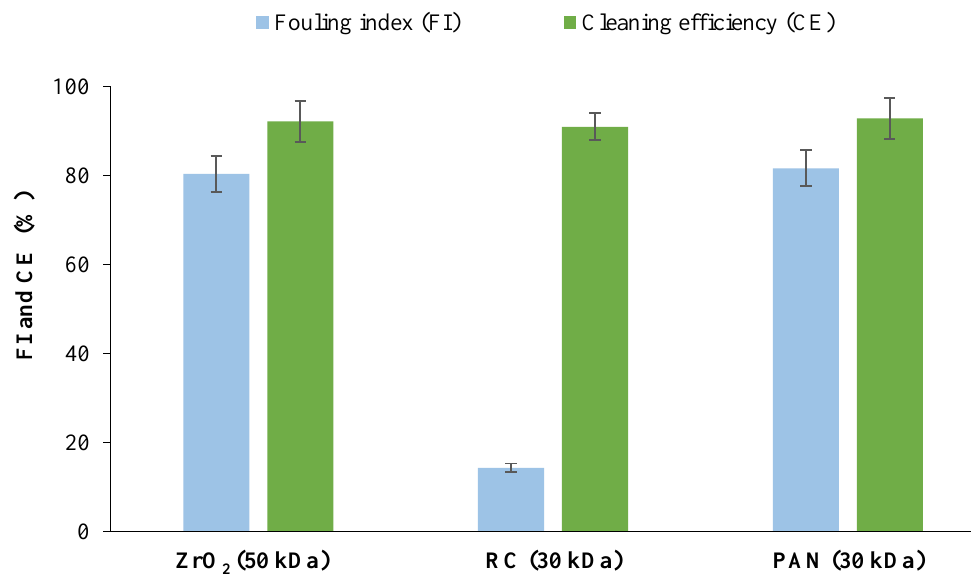
Figure 3. Fouling index and cleaning efficiency of tested membrane.